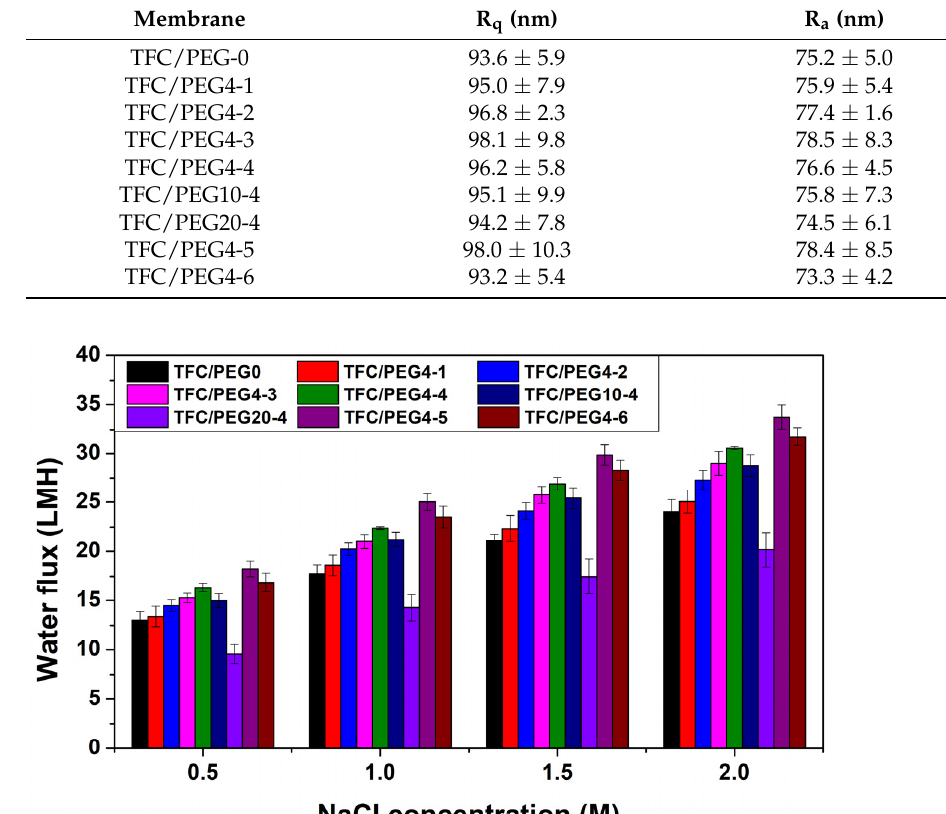
Figure 10. Water flux of PSU/PEG supported TFC-FO membranes.